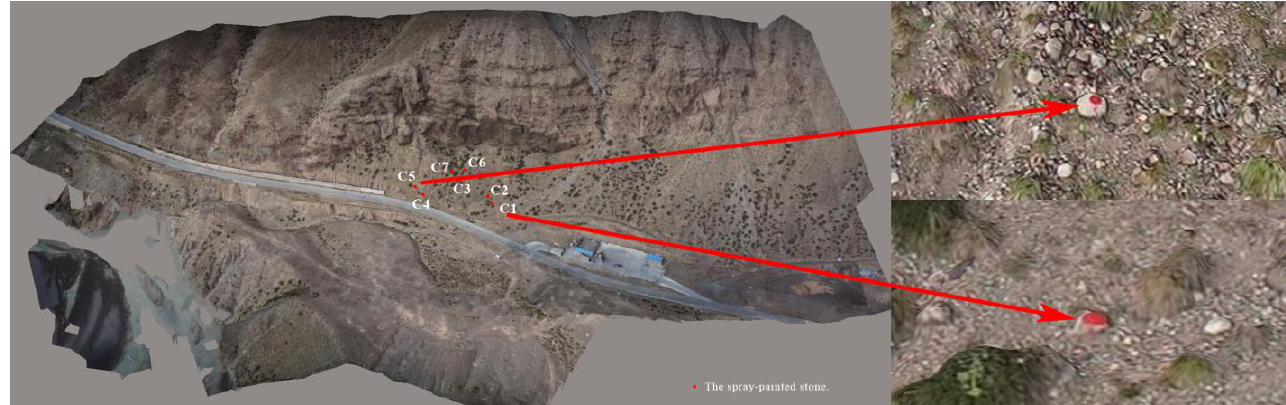
Figure 7. The 3D model of the study site and the spray-painted stones.